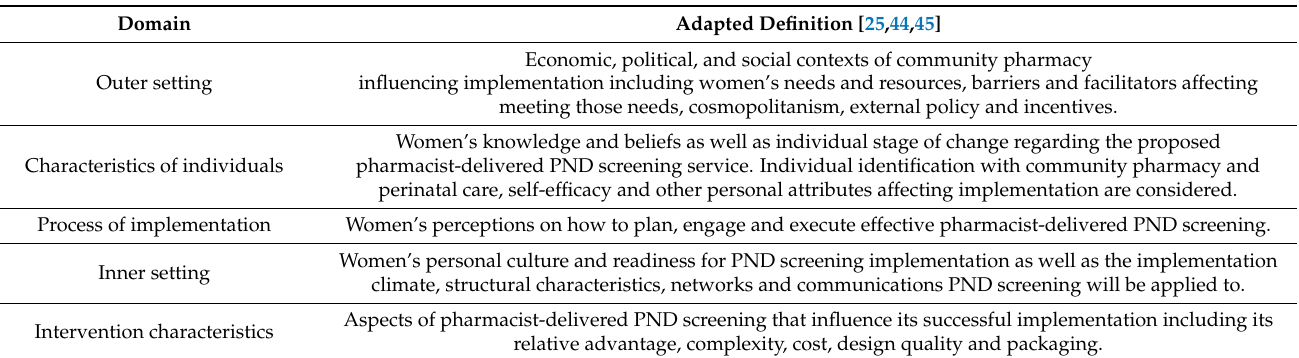
Table 1. CFIR domains in relation to pharmacist-delivered PND screening [25,44,45].